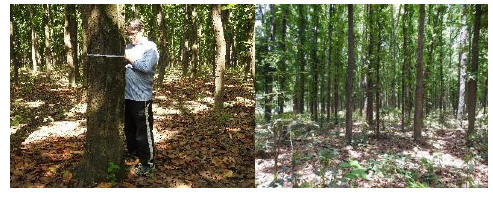
Figure 3. Field photographs. Table 4. Equations for Satellite Derived Variables